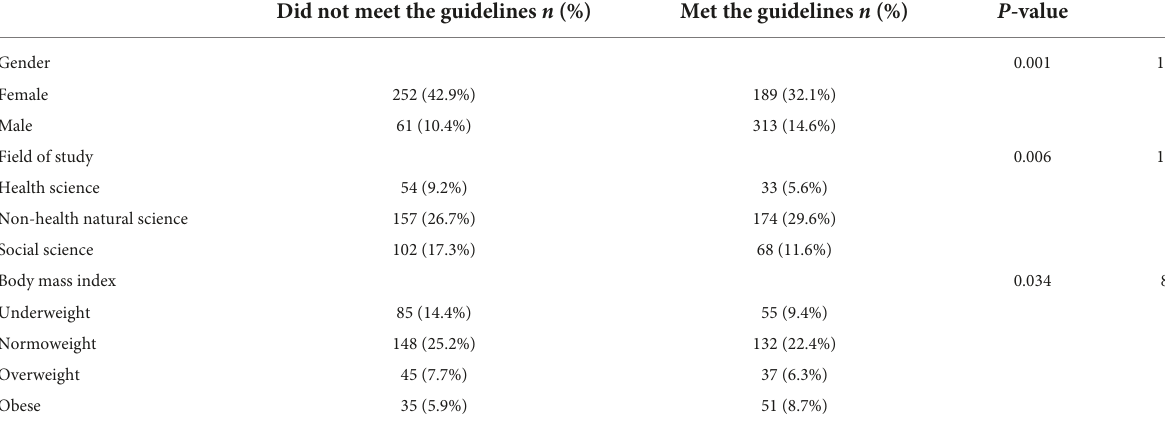
TABLE 3 Association between students’ characteristics and their physical activity (PA) levels.